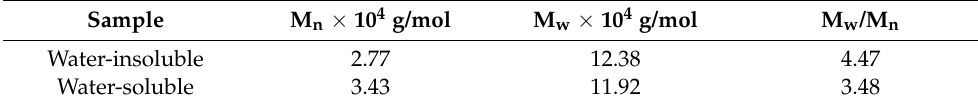
Table 1. Molar masses of water-insoluble β -glucan in oat bran.